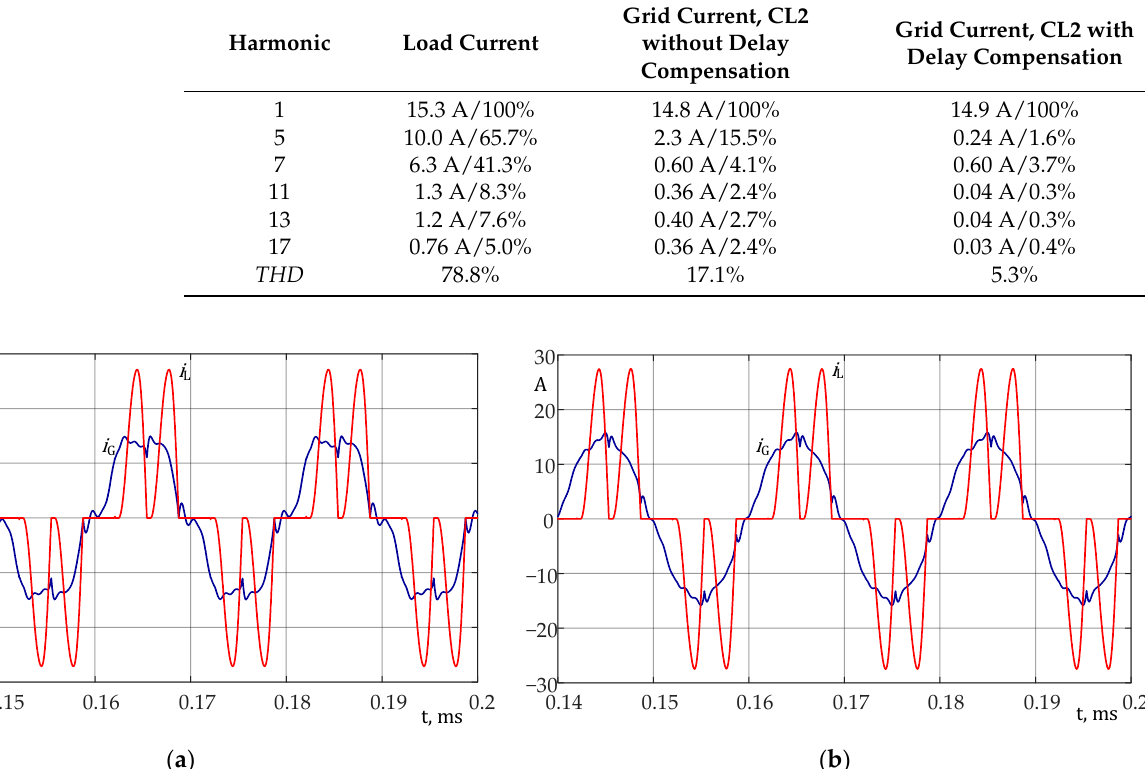
Table 1. Operation comparison for hybrid active power filters (HAPF) with CL2 control loop without and with time delay compensation.